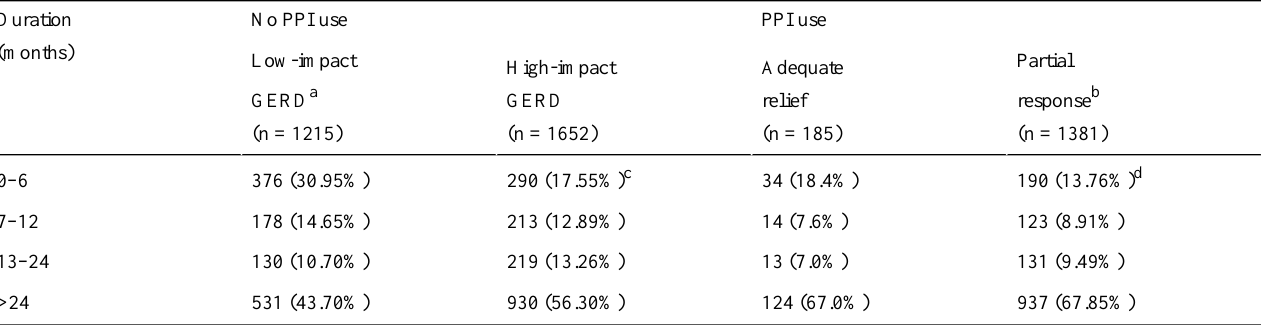
Table 3. Duration of symptoms in respondents with and without proton pump inhibitor (PPI)